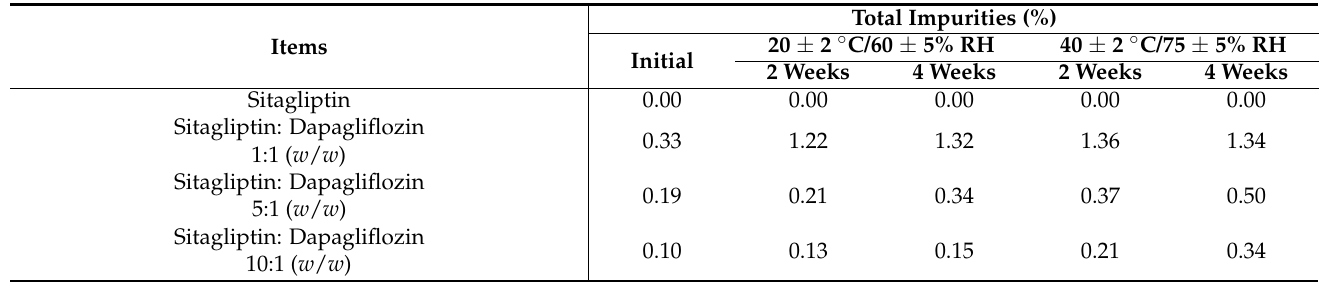
Table 6. Results of compatibility testing between sitagliptin phosphate monohydrate and vari- ous